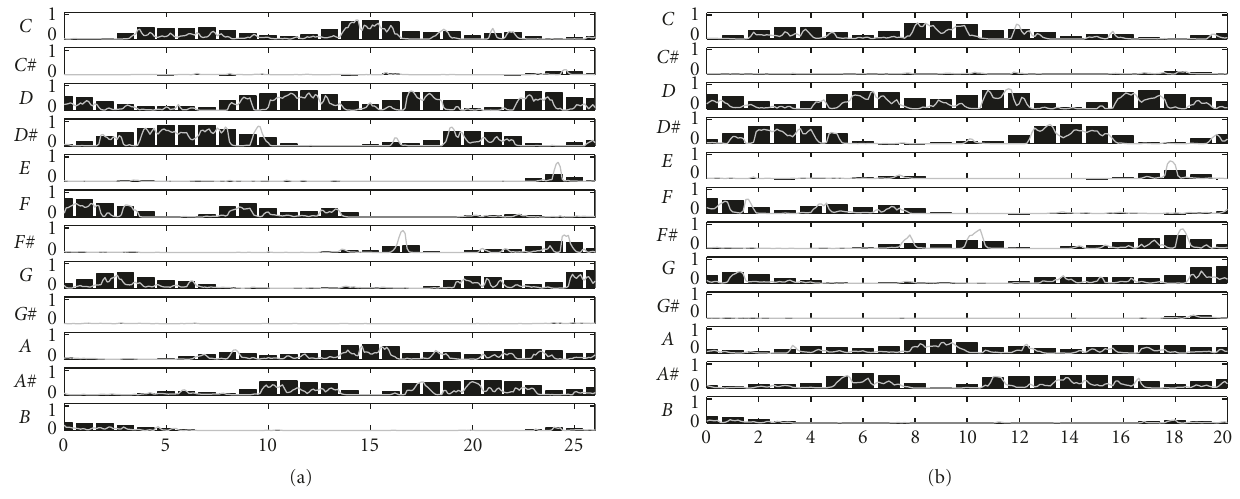
Figure 5: Local chroma energy distributions (light curves, 10 feature vectors per second) and CENS feature sequence (dark bars, 1 feature vector per second) of the segment [42 : 69] ((a) corresponding to B 1 ) and segment [69 : 89] ((b) corresponding to B 2 ) of the Brahms example shown in Figure 1. Note that even though the relative tempo progression in the parts B 1 and B 2 is di ff erent, the harmonic progression at the low resolution level of the CENS features is very